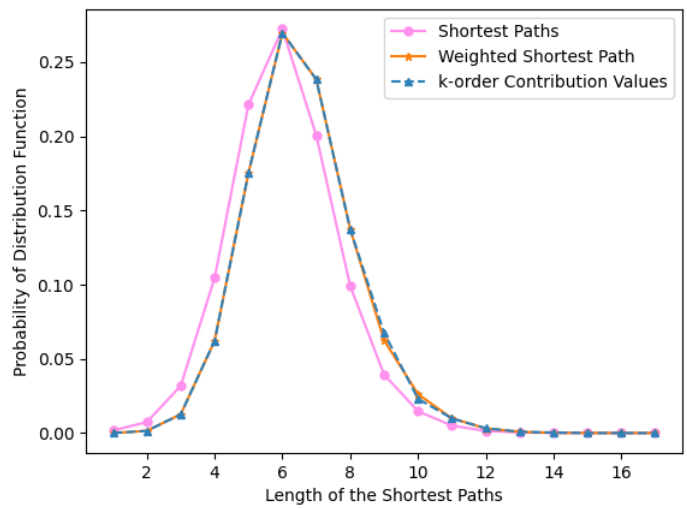
Figure 6. The distribution of weighted shortest path and the k-order contribution value on the real network with 5242 nodes and 14,496 edges, which is a collaboration network covering scientific collaborations between authors of papers submitted to general relativity and quantum cosmology categories on the e-print